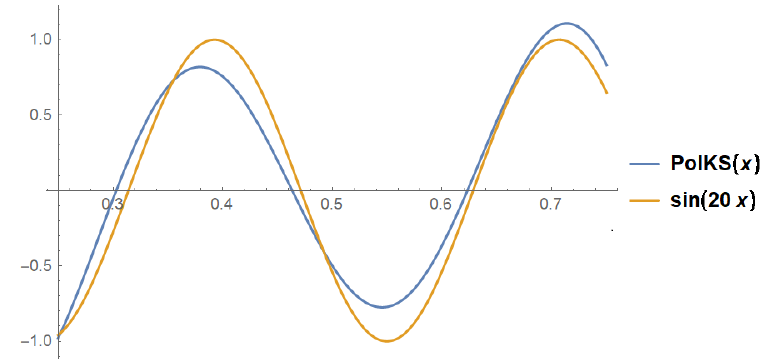
Figure 1. α = 0.1, β = 0.2, m = 25